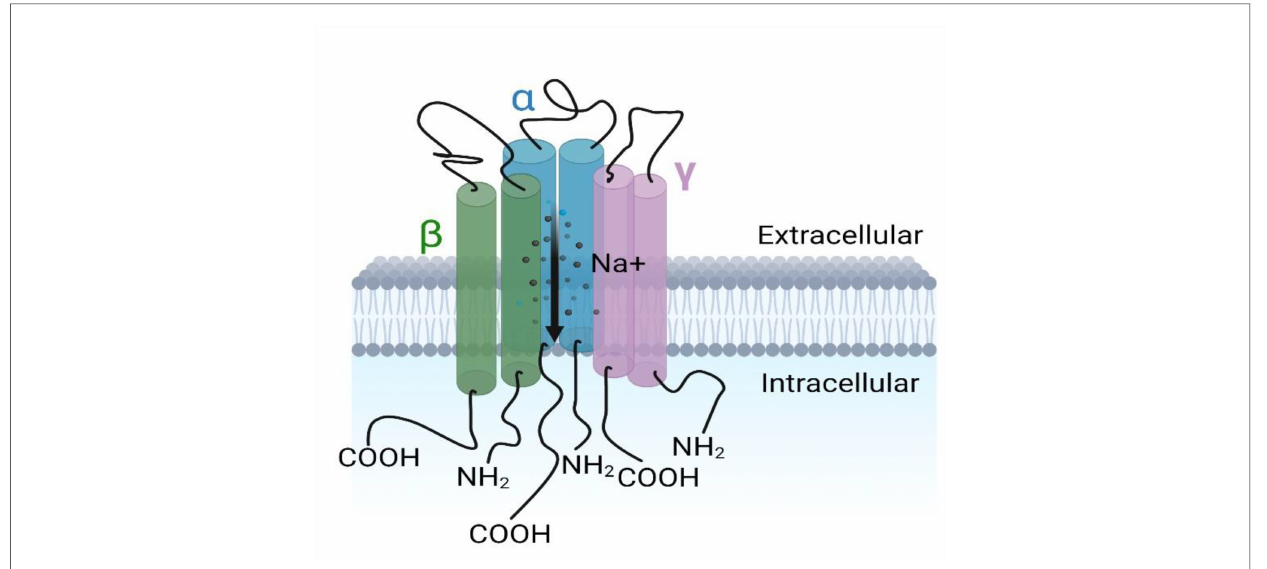
FIGURE 1 The epithelial Na + channel. Each subunit ( α , β , γ ) having the carboxyl and amino termini groups intracellular with two (2) transmembrane segments each and a large extracellular domain between